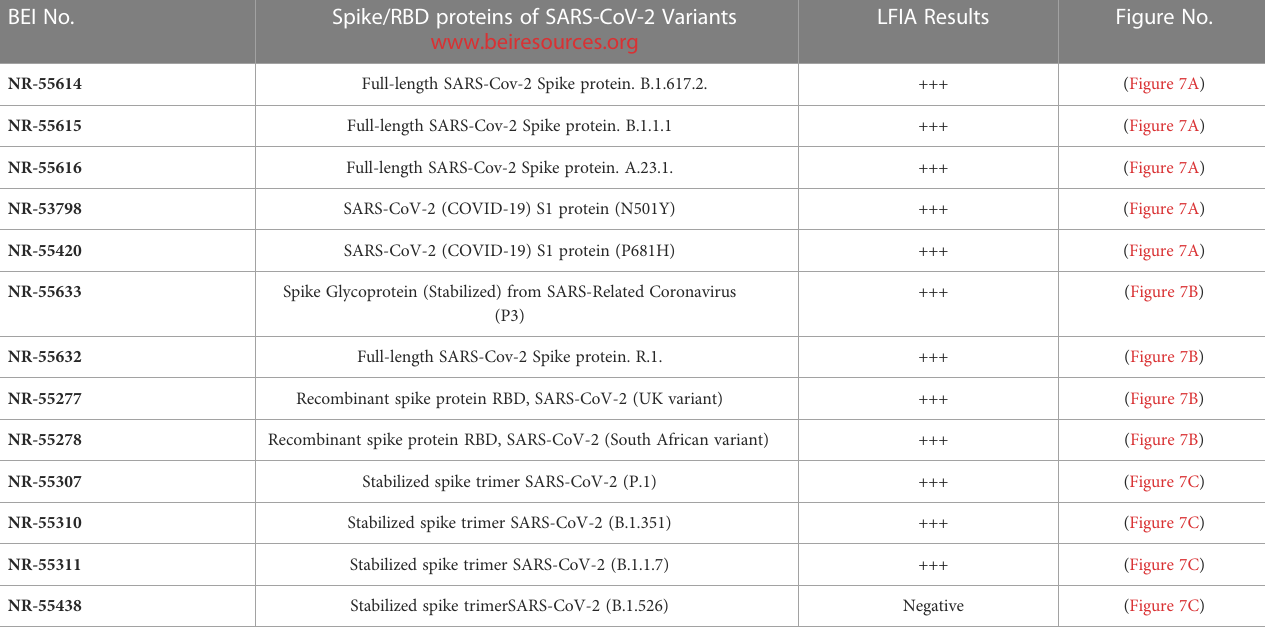
TABLE 2 LFIA Speci fi city with full-length Spike/RBD proteins of SARS-CoV-2 variants BEI